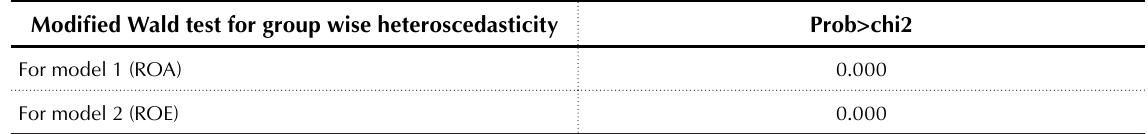
Table 6. Modified Wald test for group wise heteroscedasticity Modified Wald test for group wise